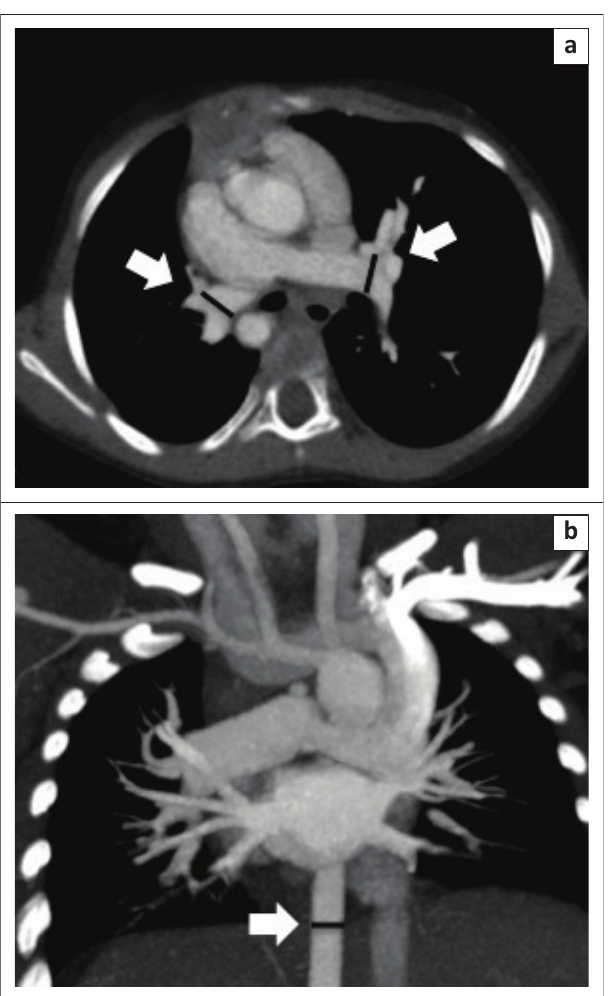
FIGURE 8: Landmarks to determine an accurate McGoon index: The sum of the RPA and LPA (a) prior to their first order bifurcation divided by the calibre of the aorta at the diaphragmatic hiatus (b).